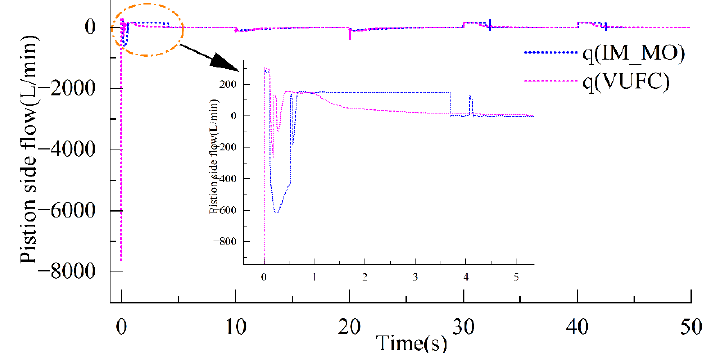
Figure 19. Piston-side flow.